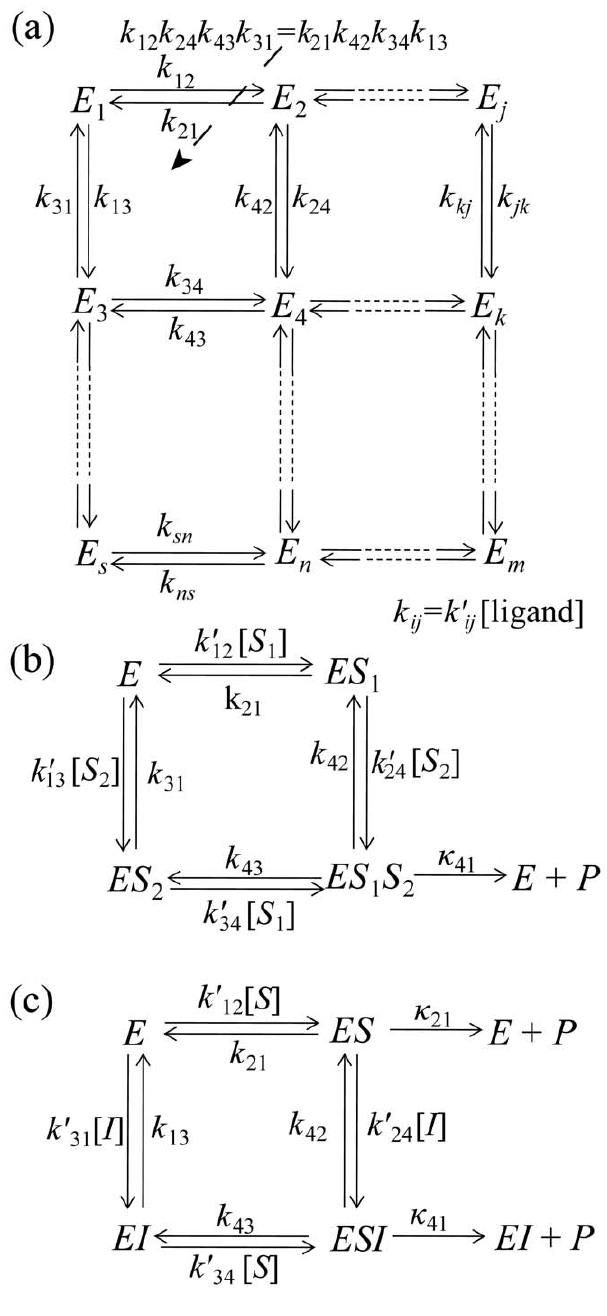
Figure 1. Reaction schemes under consideration. (a) Schematic diagram of the transitions between various states of enzyme for an arbitrary reaction scheme discussed in Methods. The detailed balance condition is shown for the loop comprised by states 1—4. For simplicity only reversible transitions are shown and catalytic transitions are omitted. The rate constants for ligand-binding reactions are propor- tional to concentrations as indicated. (b) Reaction scheme for random order bisubstrate reaction. (c) Reaction scheme for partial noncompet- itive inhibition.